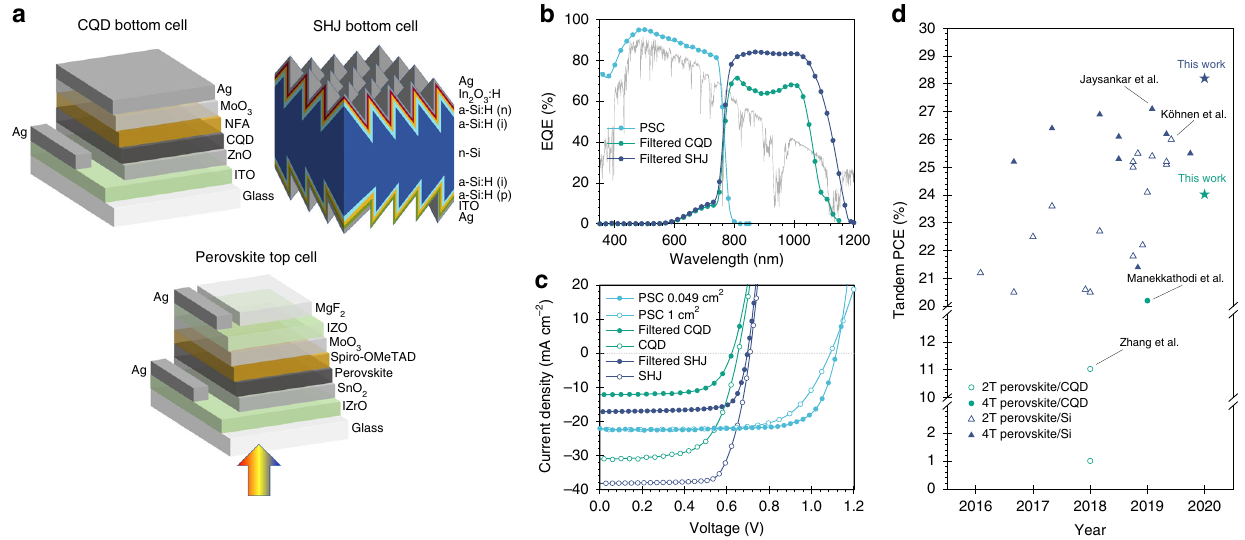
Fig. 6 Design and photovoltaic performance of mechanically stacked tandem solar cells. a Device structures of perovskite top cell, CQD, and SHJ bottom cell. b EQE spectra (overlaid with AM1.5 G) and c JV curves of perovskite top cell, CQD:organic hybrid bottom cell and SHJ bottom cell in the 4T tandem con fi guration. d PCE progress of perovskite-based tandem solar ef fi ciency in the visible (400 – 600 nm) range, leading to an improved J sc from the SHJ as a bottom cell compared to the reference SHJ designed to work at one sun condition (Fig. 5f).